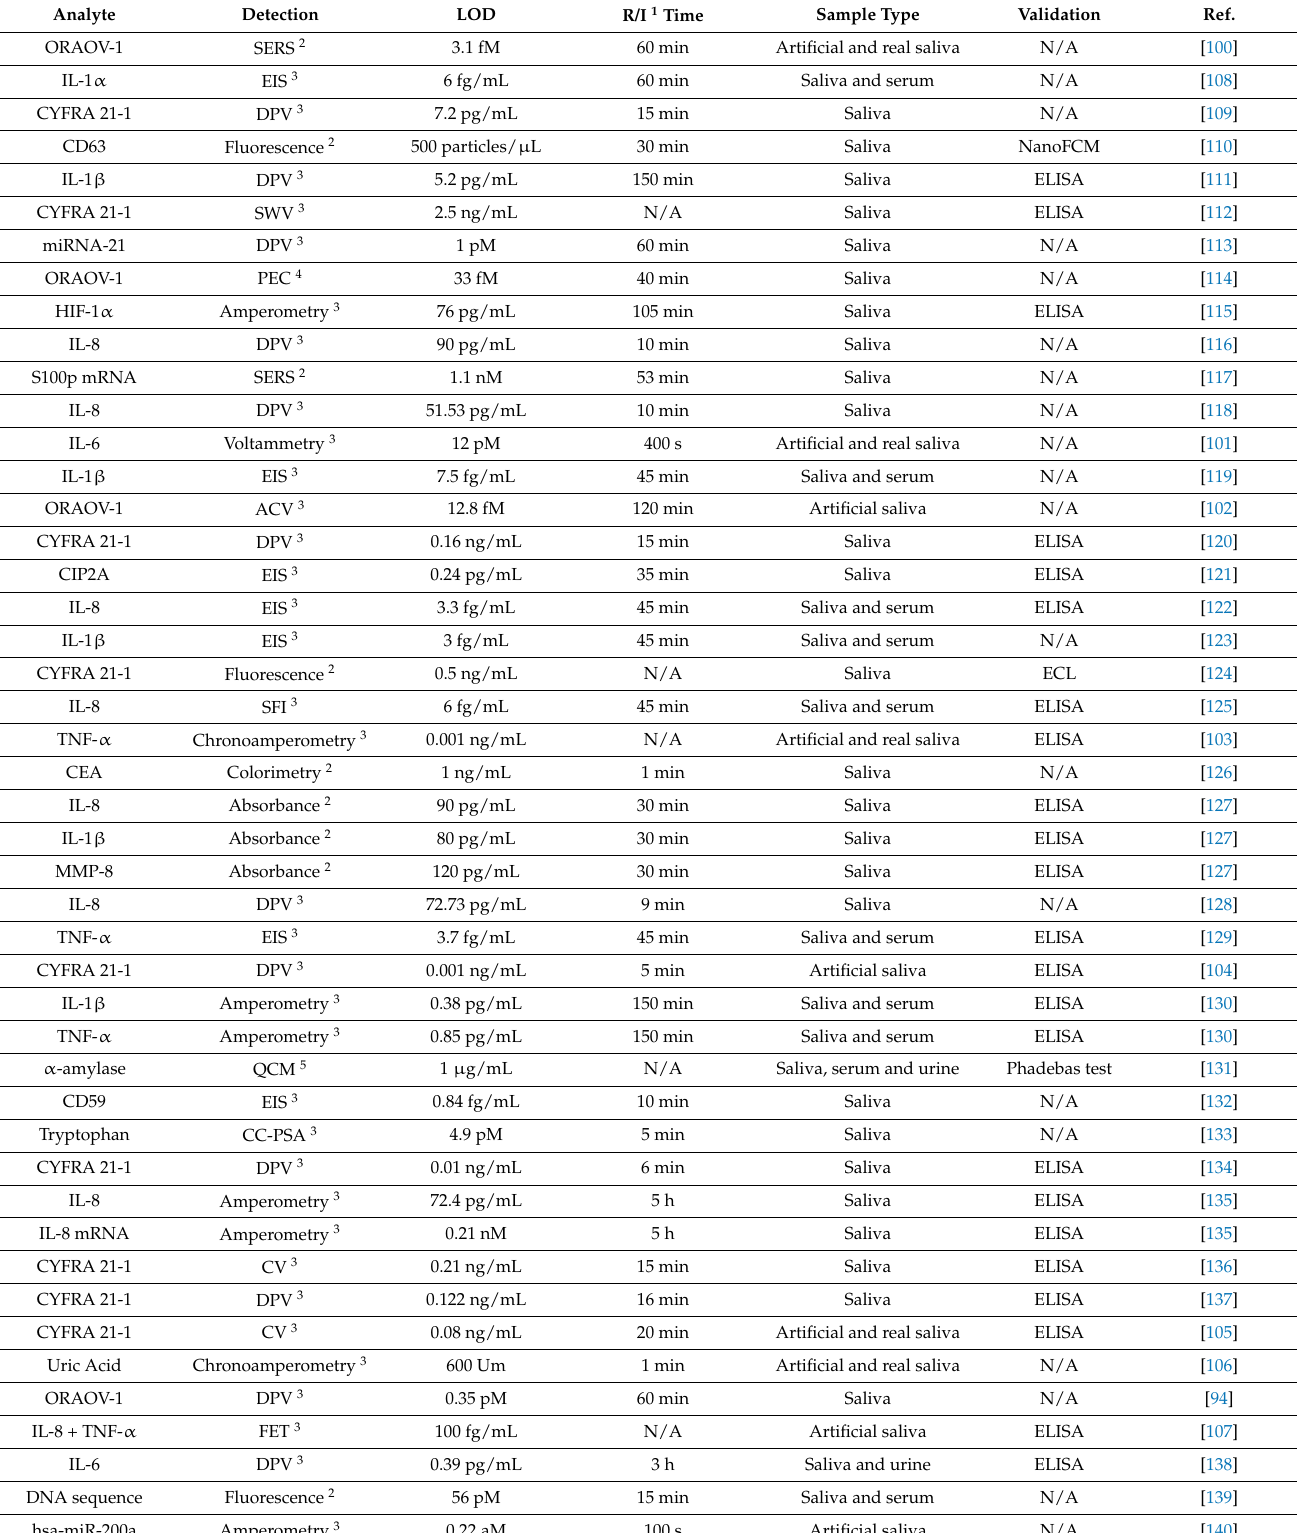
Table 1. Summary of recent studies of biosensors and bioelectronic systems for early diagnosis of oral cancer (2010-present).